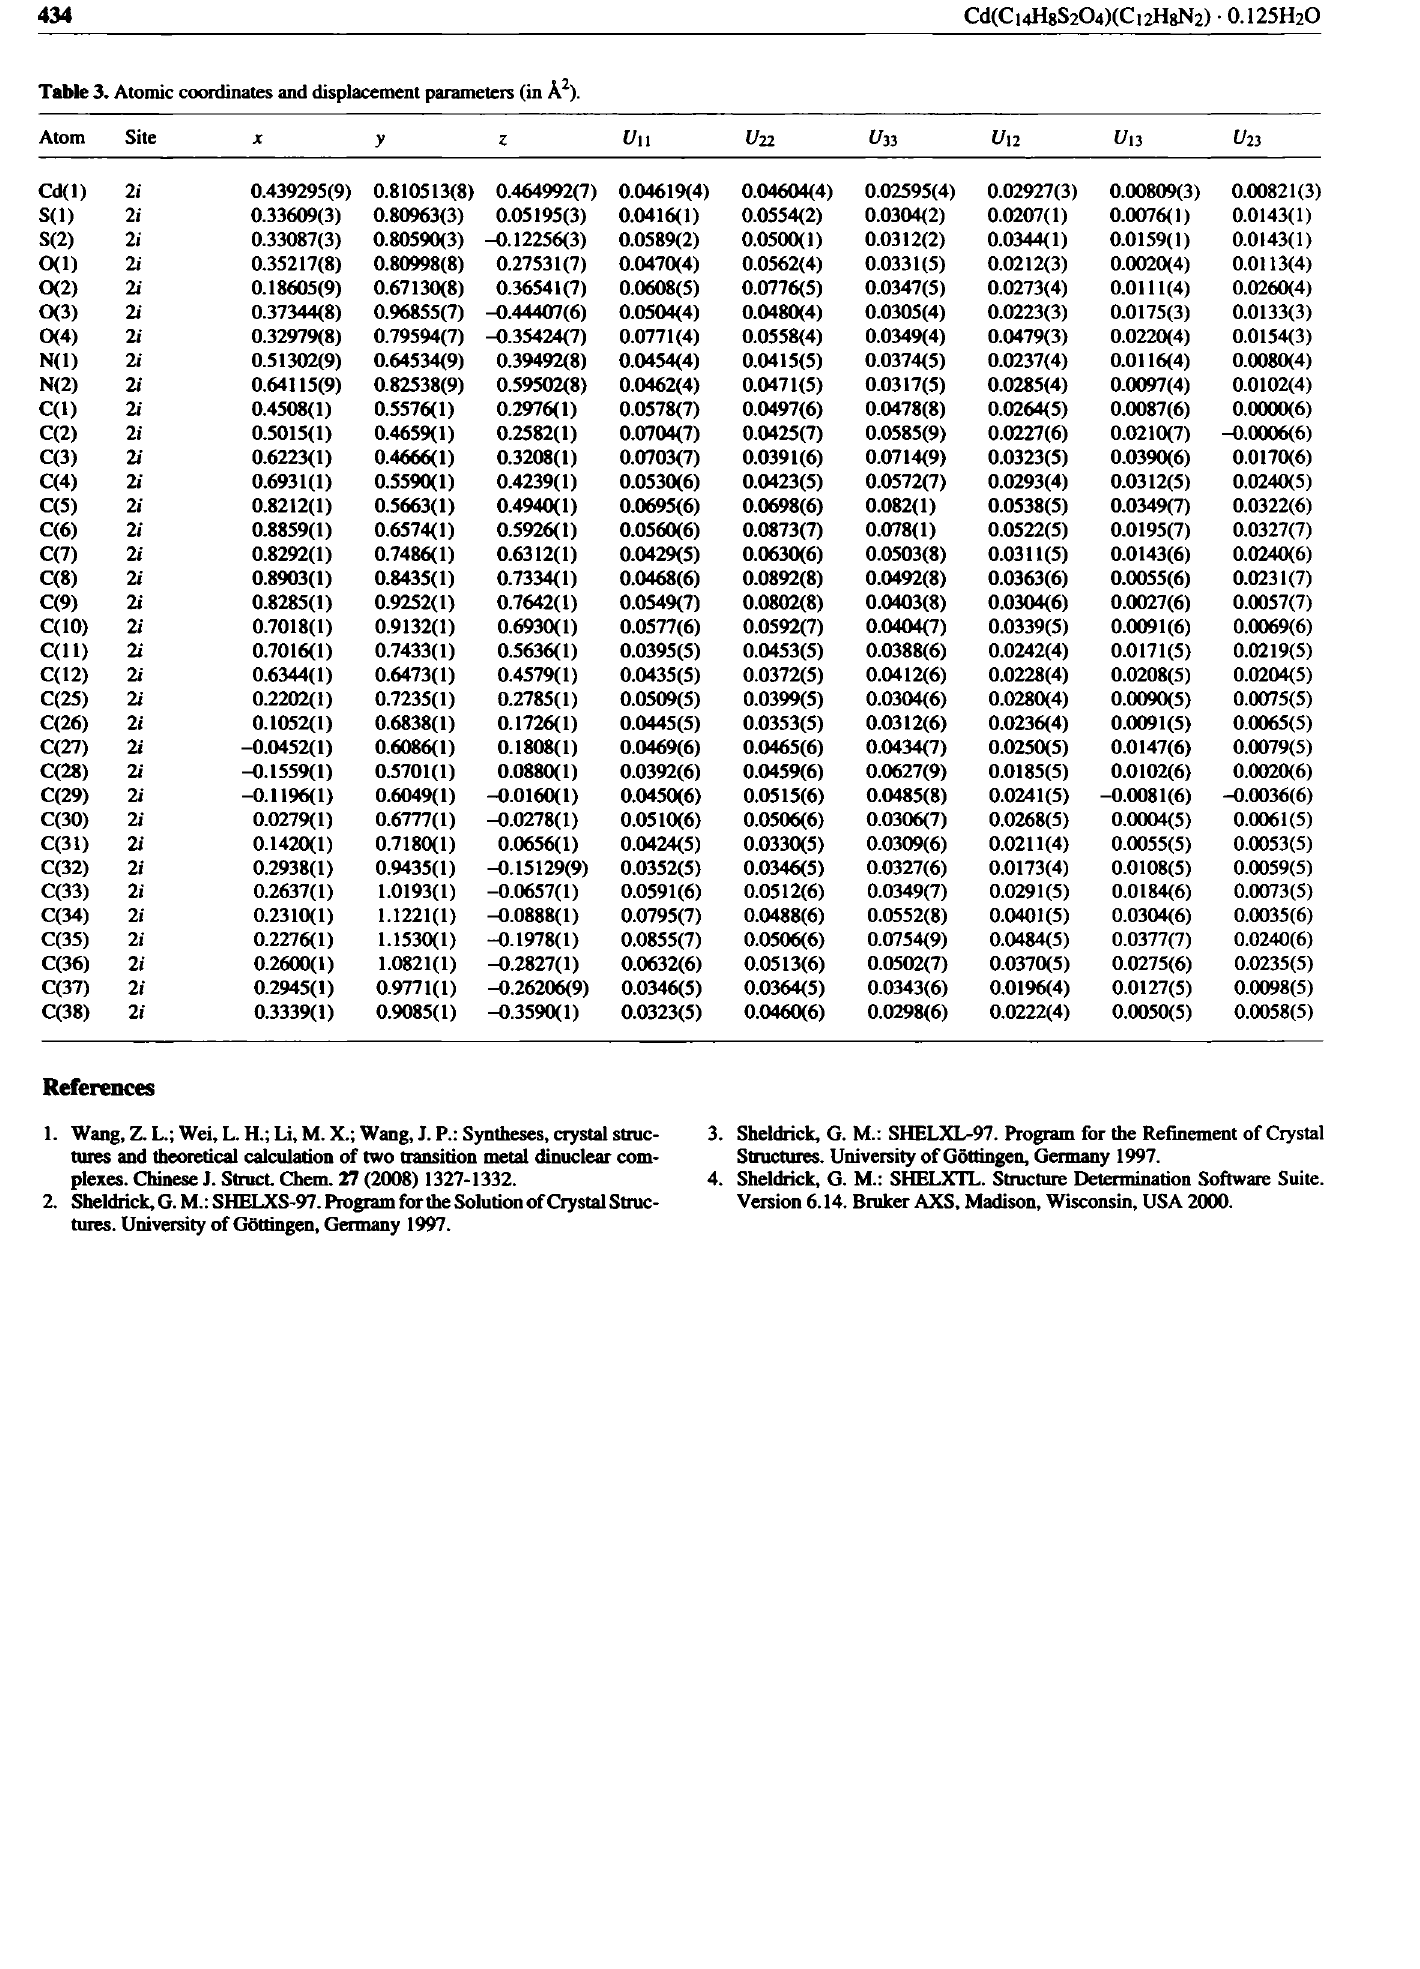
Table 3. Atomic coordinates and displacement parameters (in À 2